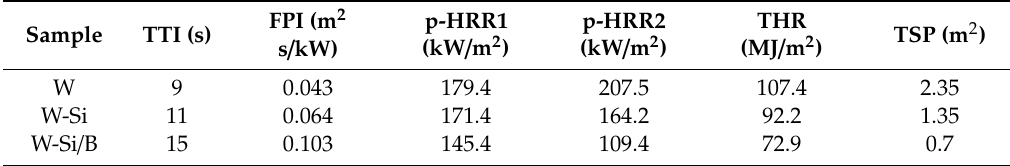
Table 1. Cone calorimetry test results of